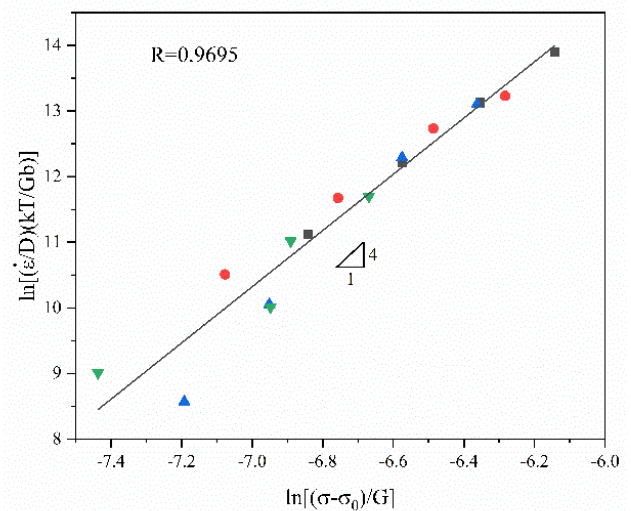
Figure 15. Normalized curve of GAZ211 alloy. The data points are normalized experimental data.